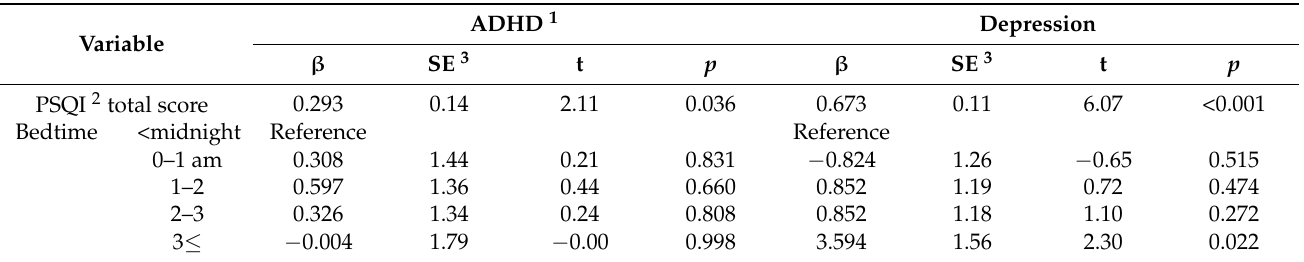
Table 3. Association of sleep quality and bedtime with ADHD and depression by multivariate regression analysis. ( n =